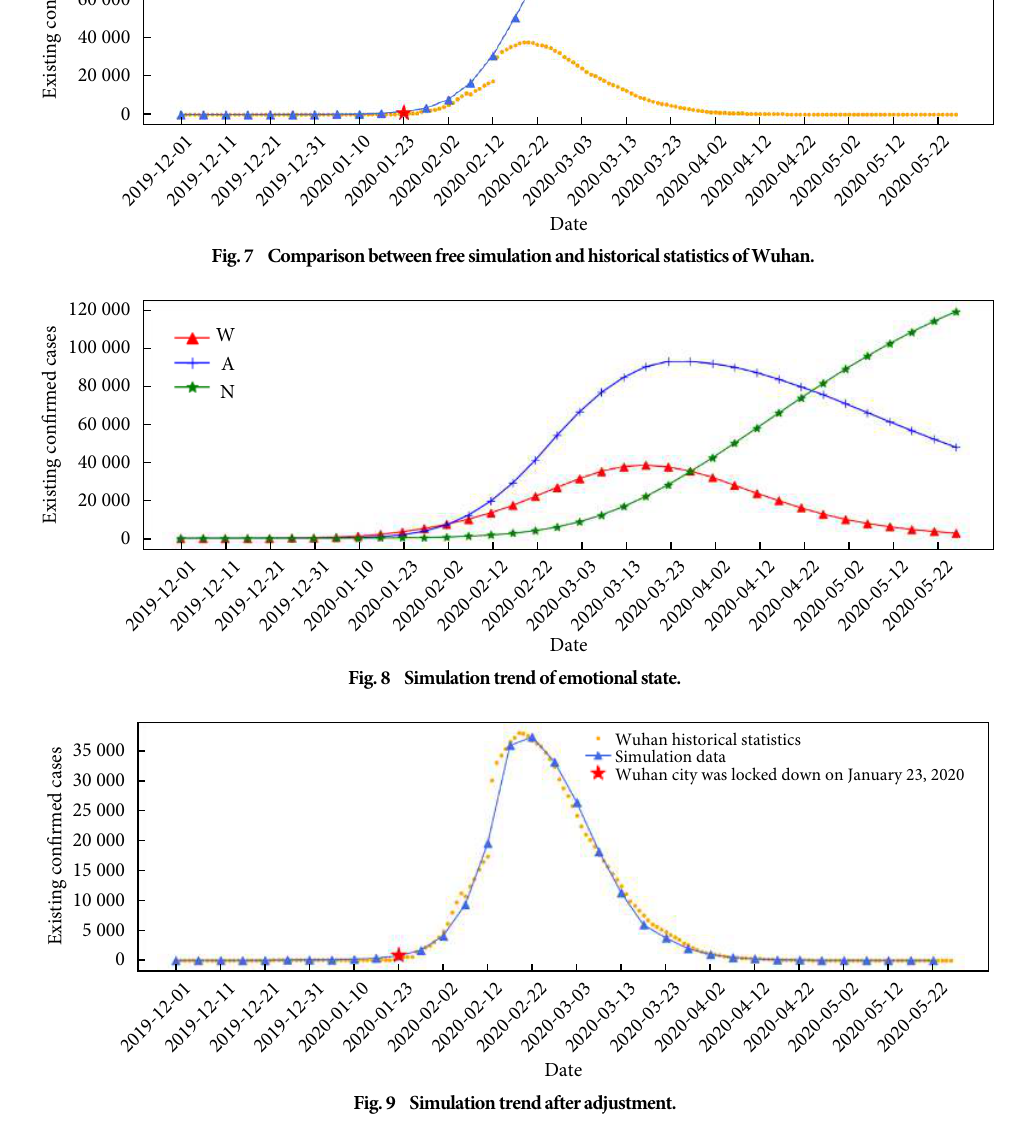
Fig. 9 Simulation trend after